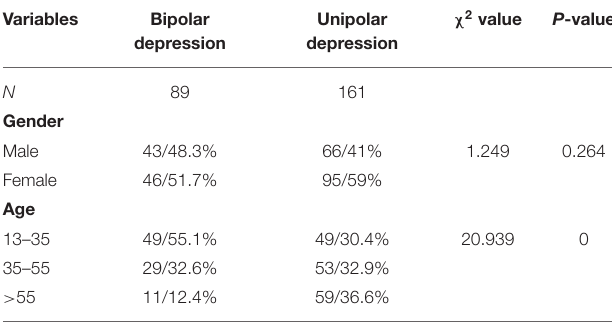
TABLE 6 | Correlations of age and gender with unipolar and bipolar depression in patients who developed the disease in winter.